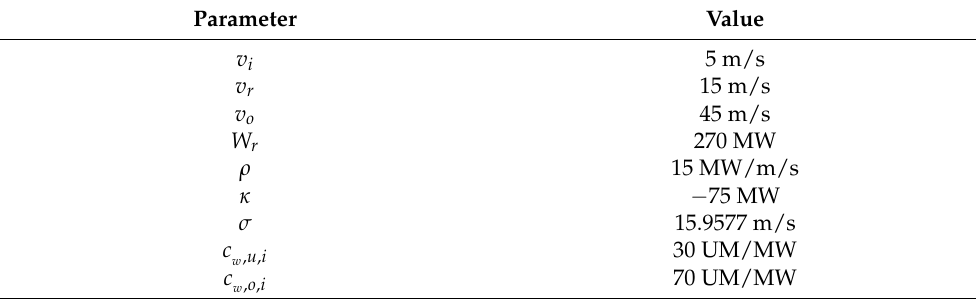
Table 1. Parameters taken for the cost function of the wind generator.